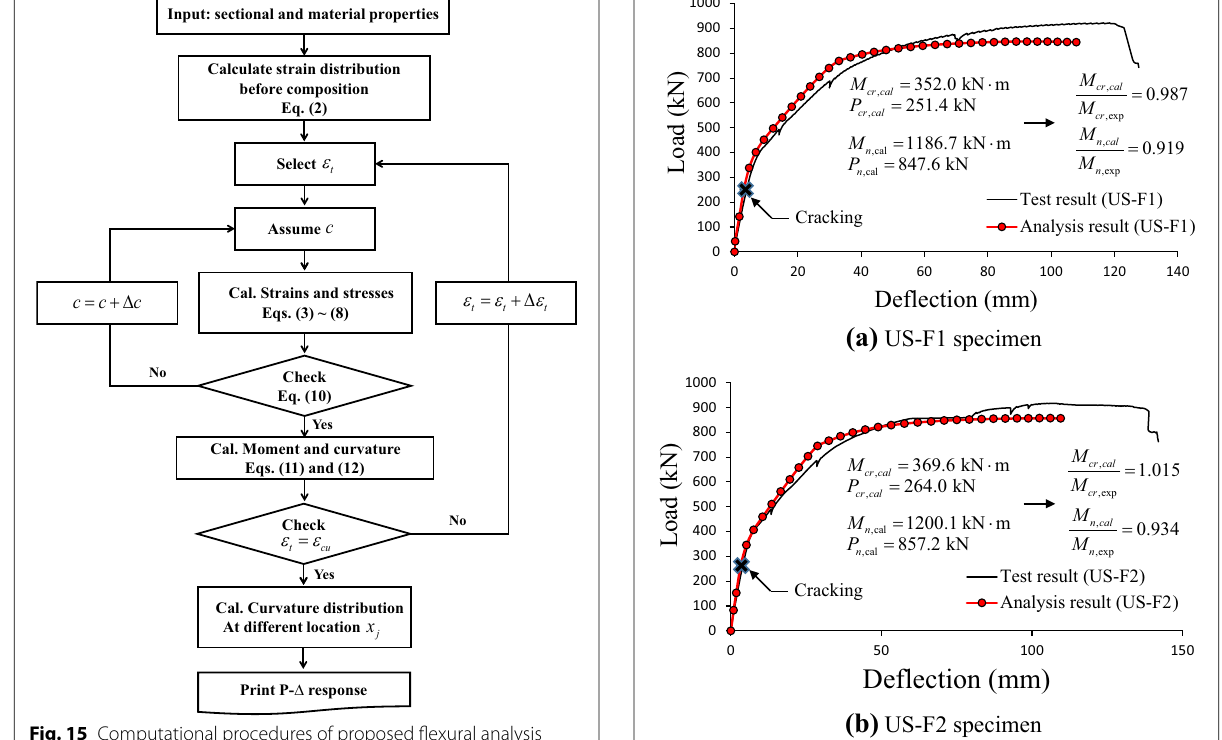
Fig. 15 Computational procedures of proposed flexural analysis model. Fig. 16 Verification of proposed flexural analysis